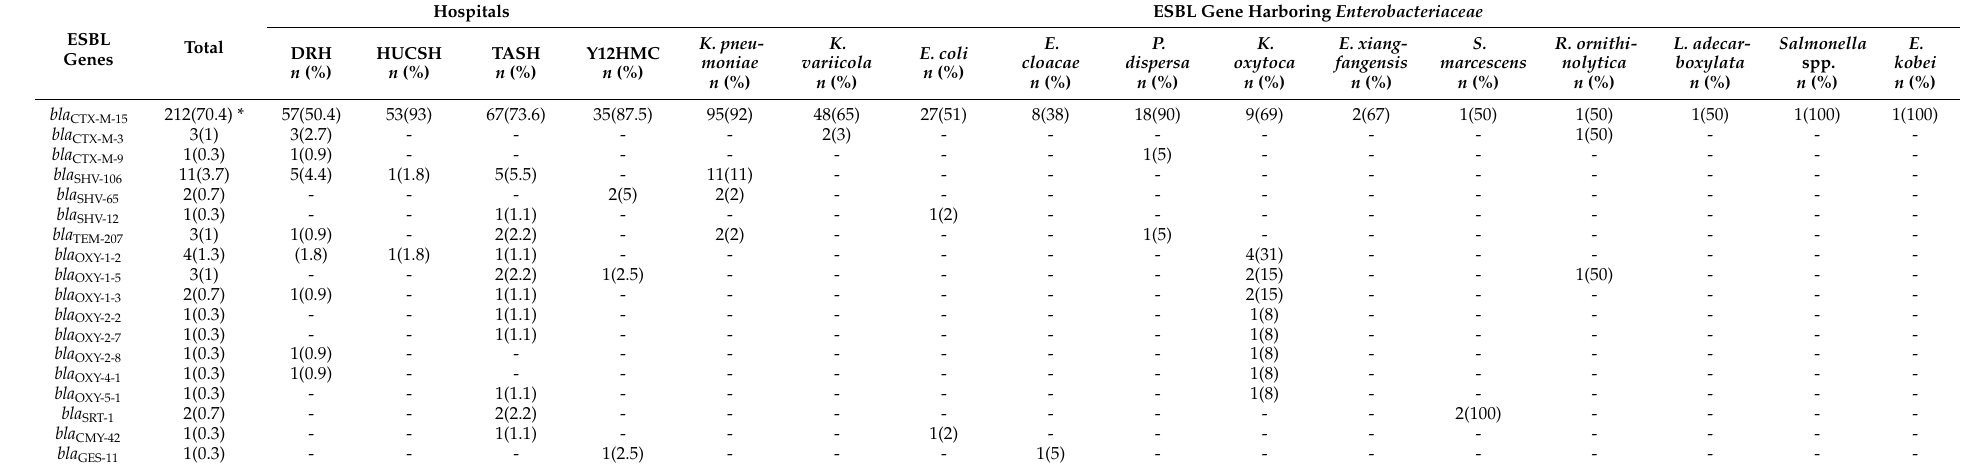
Table 4. Frequency and distribution of ESBL-encoding genes detected at four Ethiopian